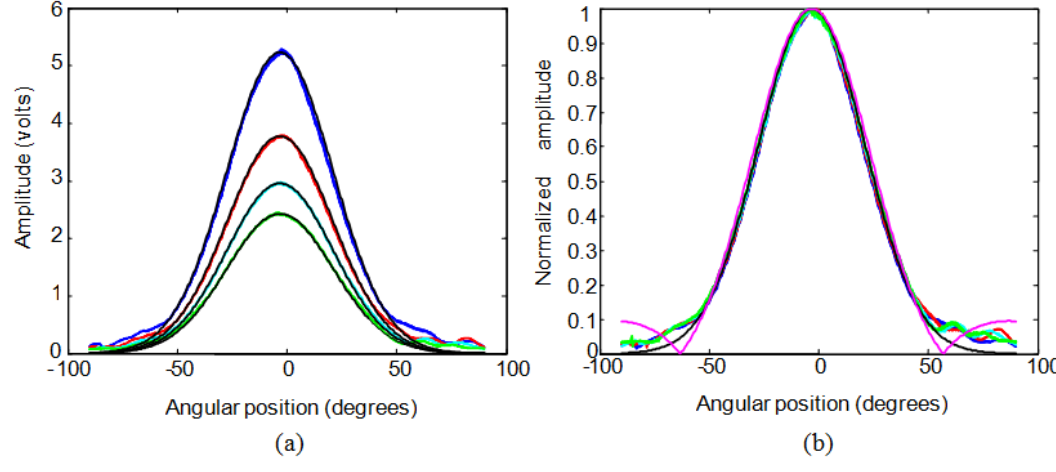
Figure 4. Angular position versus real and approximated pressure ( a ) without normalization ( b ) normalized.